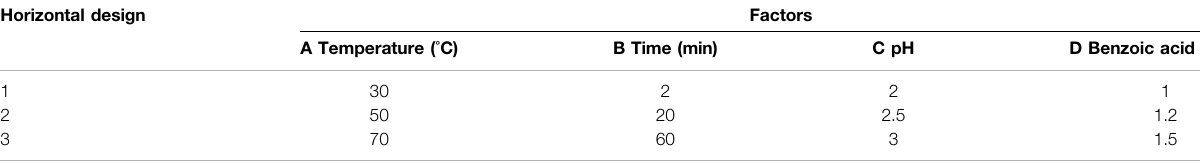
TABLE 1 | Orthogonal experiments and horizontal design.